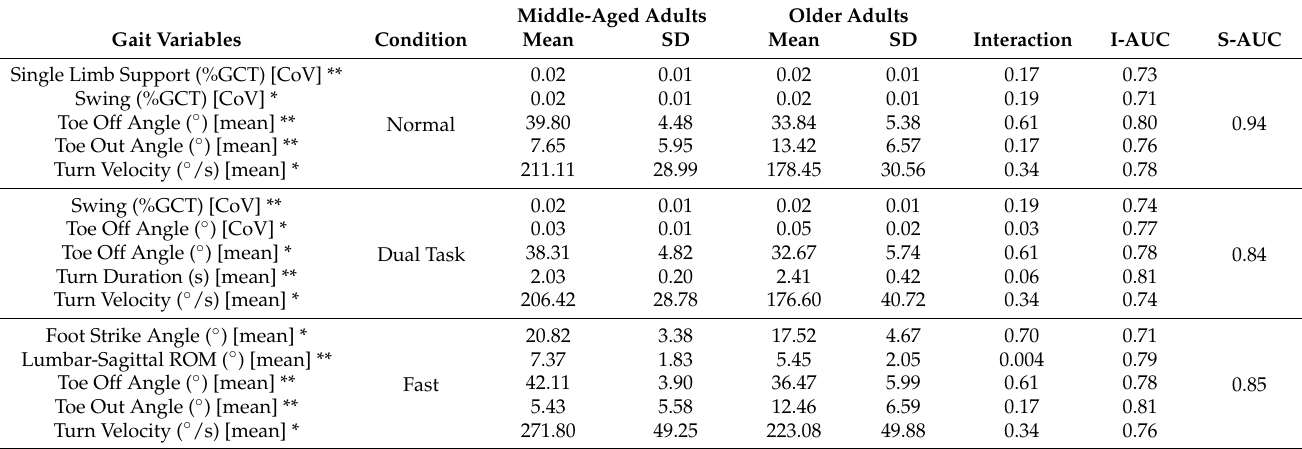
Table 3. Top five AUC producing gait variables for each walking condition, their associated means ± SD, RMANOVA group by condition interaction p -value, independent AUC (I-AUC) value, and stepwise regression AUC (S-AUC) value. Variable(s) with a single (*) were included in the stepwise regression, those with a (**) were maintained in the regression for further AUC assessment and discriminatory ability. %GCT—percent gait cycle time, COV—coefficient of variation, ROM—range of